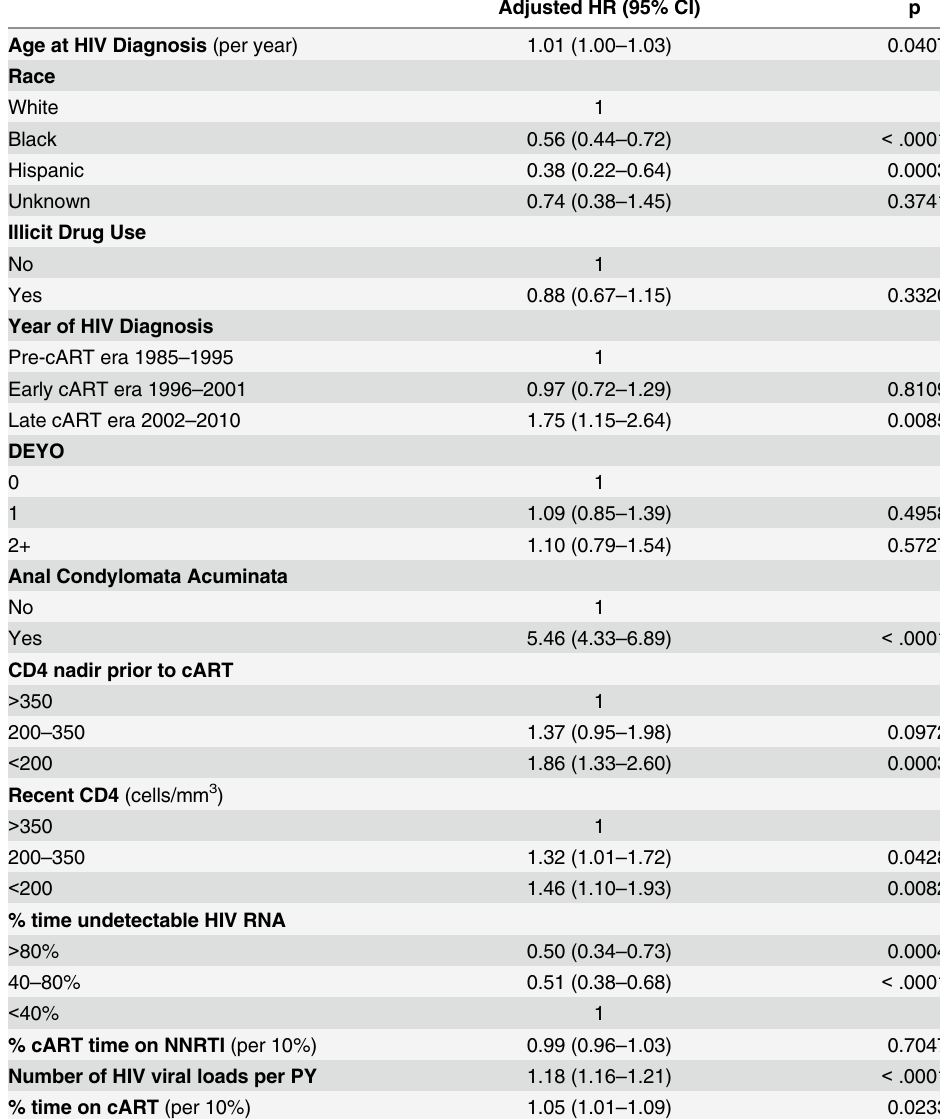
Table 3. Regression Analysis – Association between NNRTI (with Percent Time on cART and Percent Time Undetectable HIV RNA) & Time to Development of Squamous Cell Carcinoma of the